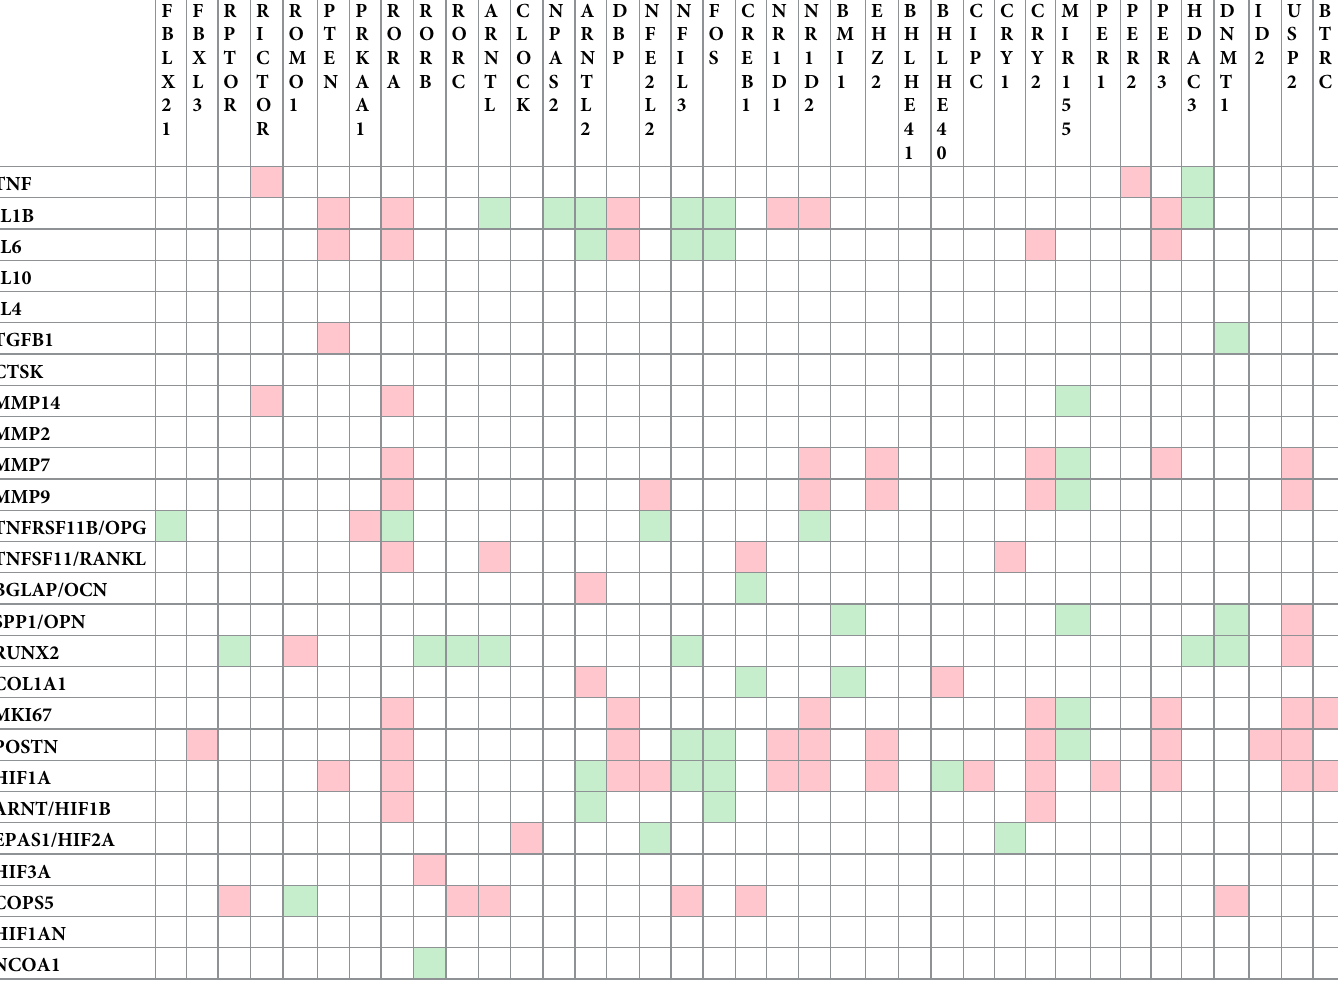
Table 3. Significant correlations of circadian rhythm genes with inflammation, tissue destructive/remodeling, bone biology, and hypoxia genes from cross-sectional study in healthy and naturally-occurring periodontitis gingival